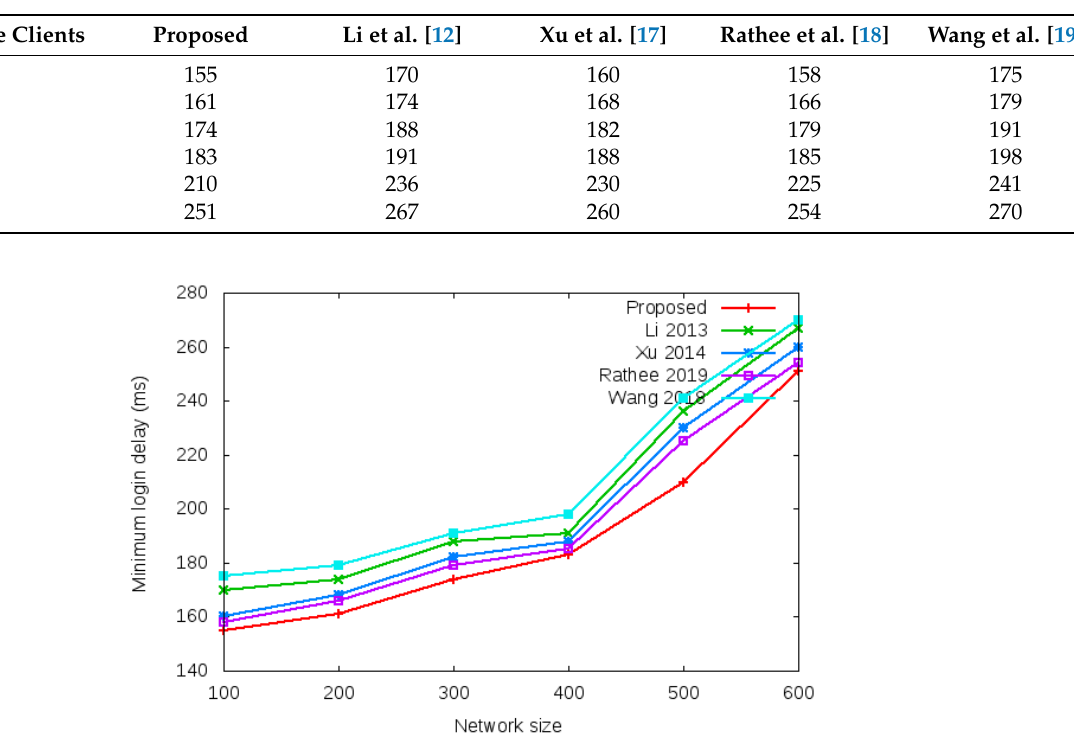
Table 5. Comparison on minimum login authentication delay.